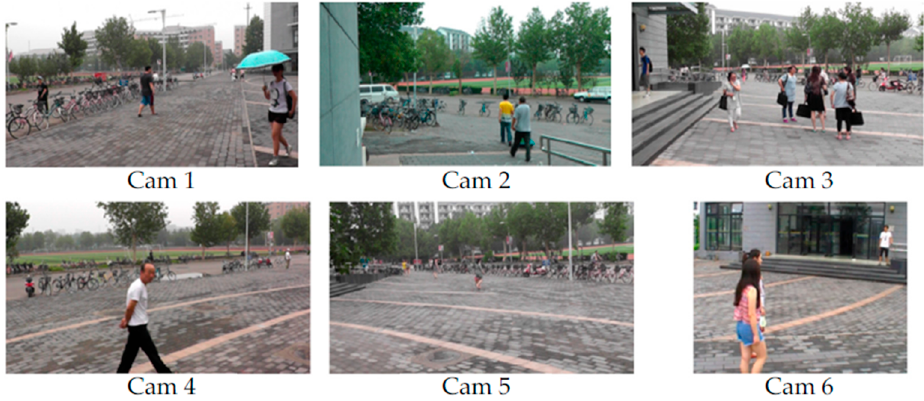
Figure 5. Example images captured by six cameras in the PRW dataset [70].